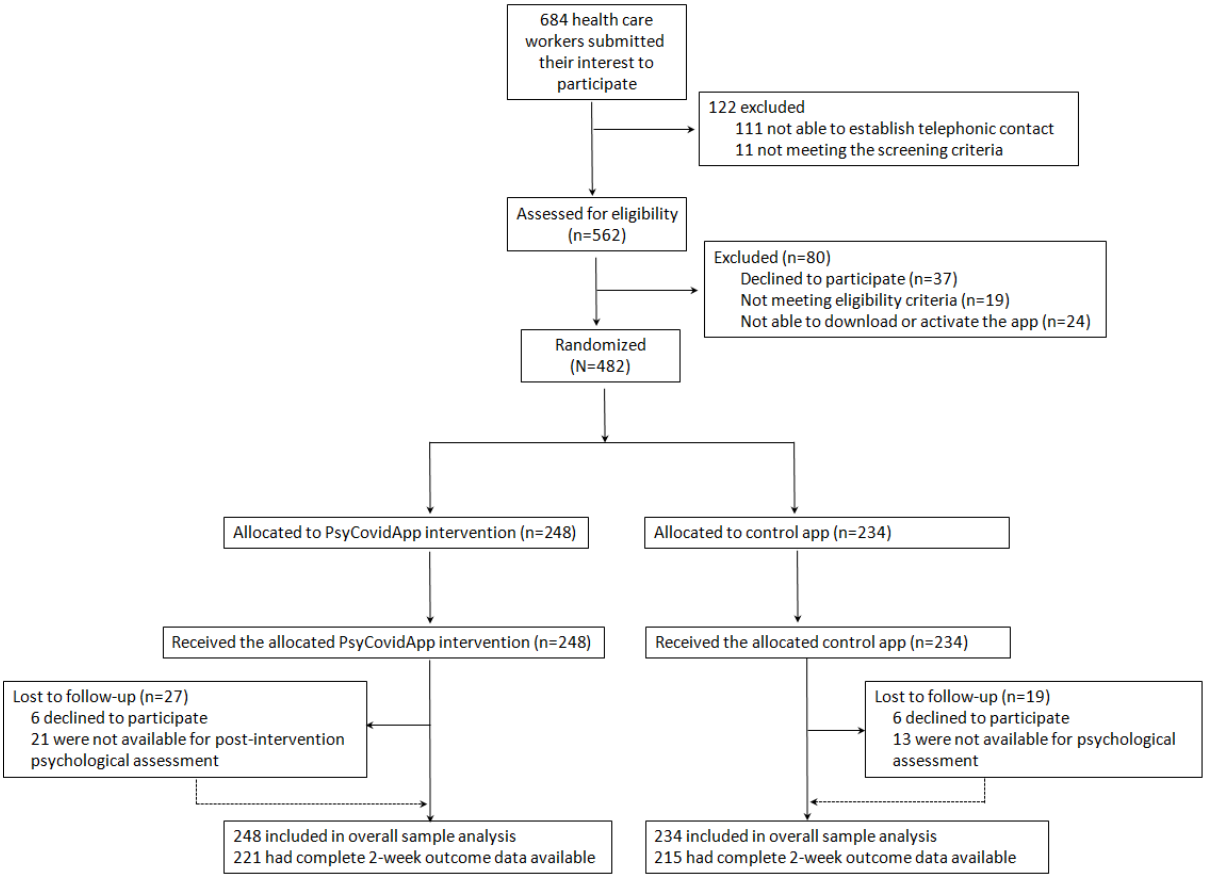
Figure 1. Trial profile. Multiple imputation was used to facilitate the overall sample analysis; all randomized participants contributed to the statistical